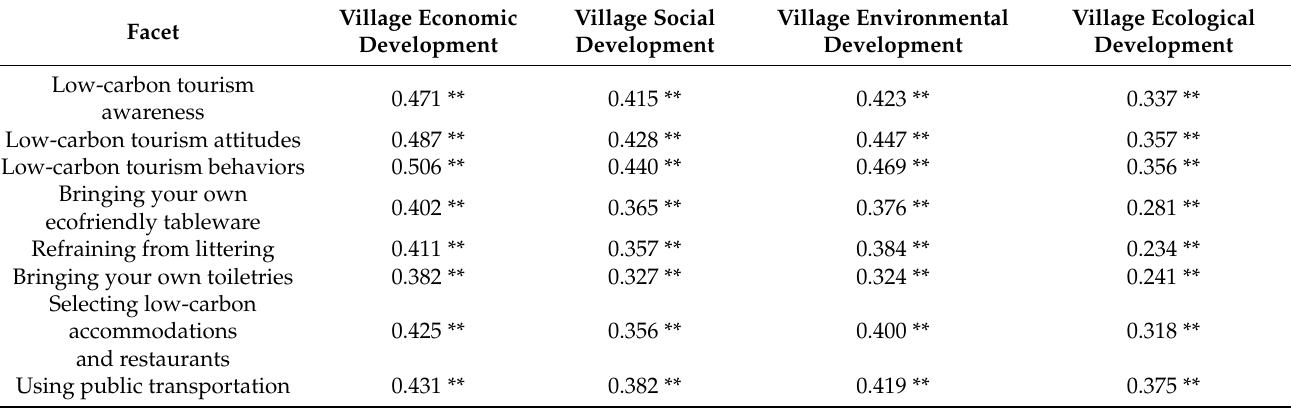
Table 4. Analysis of low-carbon tourism awareness, attitudes, and behaviors in relation to village economic, social, environmental, ecological, and environmental